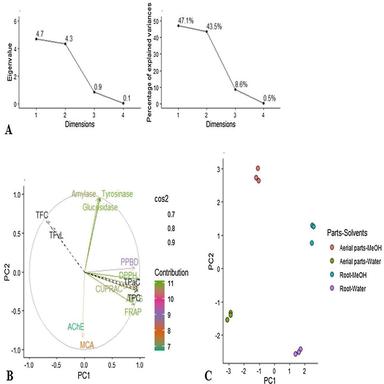
Unsupervised principal component analysis. A: Score plot of the eigenvalue and the percent of variance explained by each component. B: Correlation circle showing the contribution of biological assays to each components and the relationship between the biological activities and total phenolic contents (TPC, TFC, TPAC and TFvL). C: Projection of the samples on the 1st and 2nd factor planes.